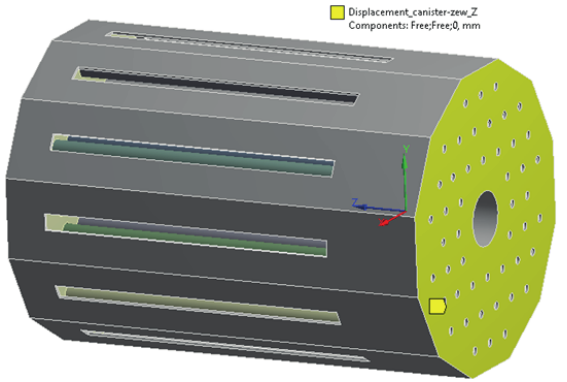
Figure 6: Structural constraints in the mSOFC stack with the supporting structure in a hexagonal configuration of fuel cells.